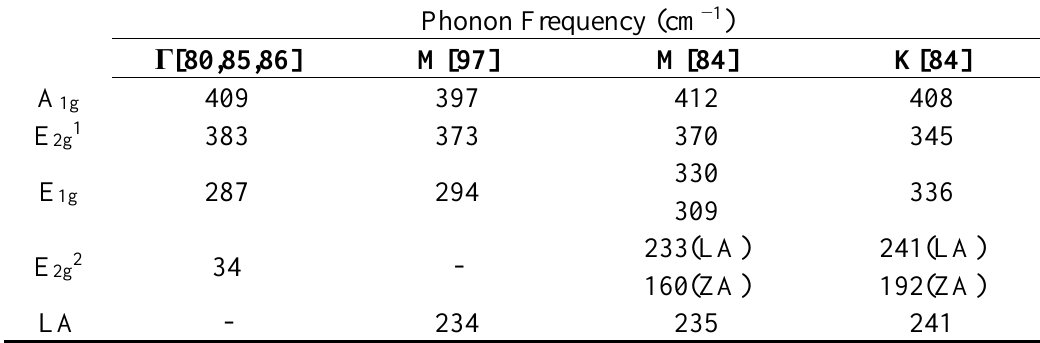
Table 4. The phonon frequency of Raman-active and LA modes at different points of the Brillouin